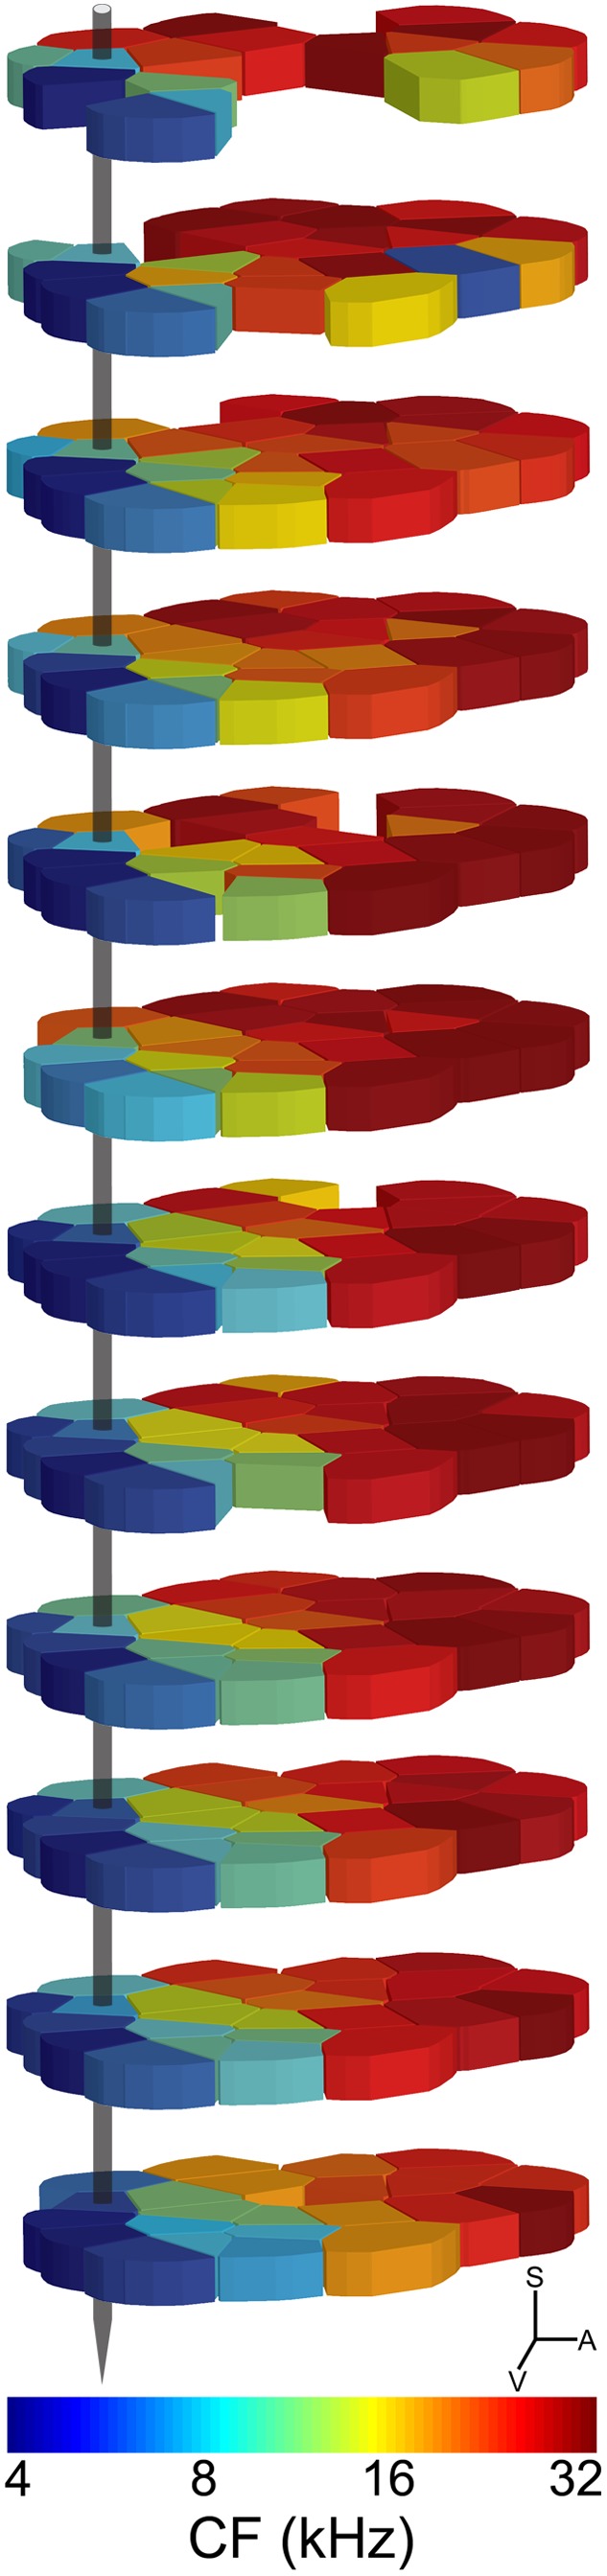
Representative example of tuning distribution within cat A1 columns.Characteristic frequency (CF) values are presented in Voronoi- tessellation form; colors identify tuning properties across twelve different cortical depths (rows). S, superior; V, ventral; A, anterior.